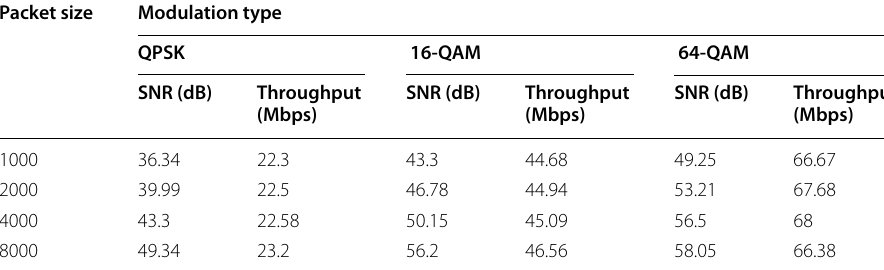
Table 4 SNR and corresponding throughput values for various packet sizes in the existing LTE system Packet